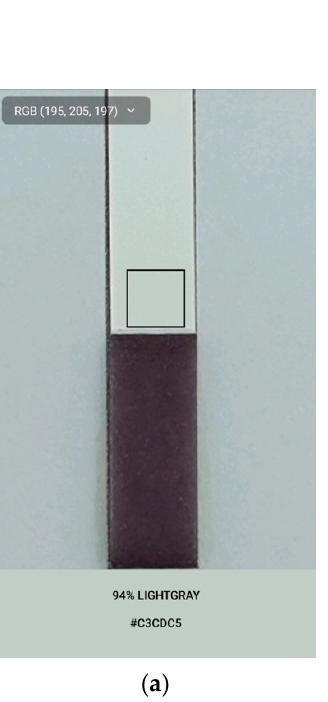
Figure 5. MTT-PMS test strip data collection procedure: ( A ) Preparation of bacteria suspension in a sample tube; ( B ) Submersion of MTT test strips for 2 min; ( C ) Recording of RGB colorimetric data using a smartphone camera. Created with BioRender.com (https://app.biorender.com/). Last ac- cessed: 10 November 2021.